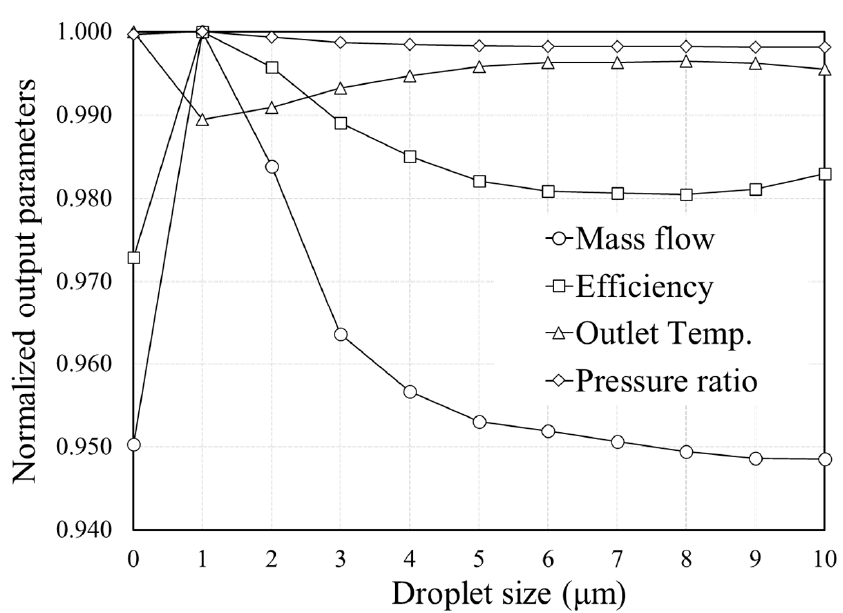
Figure 18. Effect of the different droplet sizes on the centrifugal compressor performance .